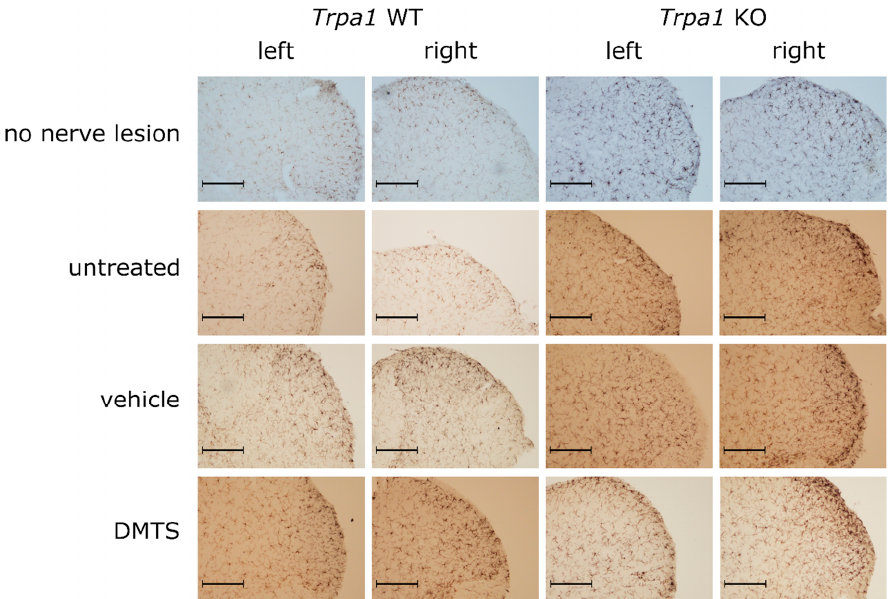
Figure 6. Representative micrographs used for the calculation of the density of IBA1-positive microglia in the spinal cord dorsal horn. Immunohistochemistry was visualized with 3,3 ′ -diaminobenzidine. Images were taken with a 10× objective. Size bars indicate 200 µm.